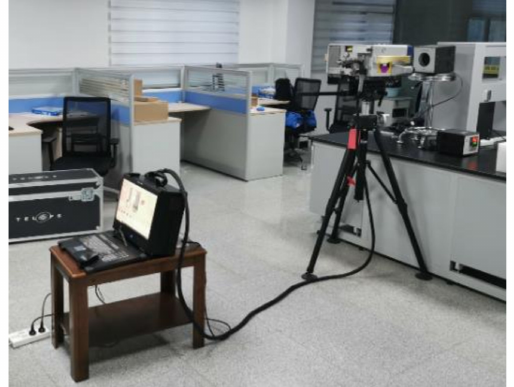
Figure 2. Instrument performance testing in the laboratory: the control computer ( left ), the Hyper- Cam LW sensor, and the temperature-tunable blackbody ( right